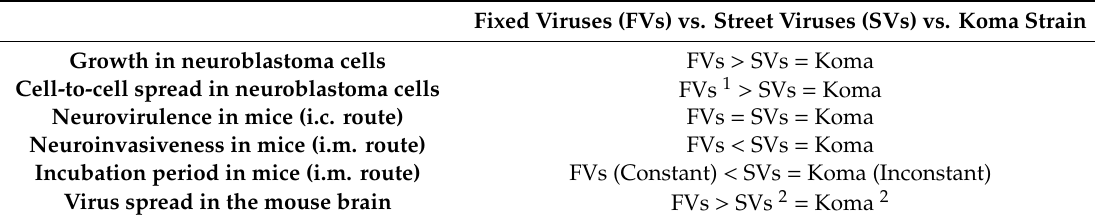
Table 4. Di ff erences between the phenotypic properties of street viruses and fixed viruses. Fixed Viruses (FVs) vs. Street Viruses (SVs) vs. Koma